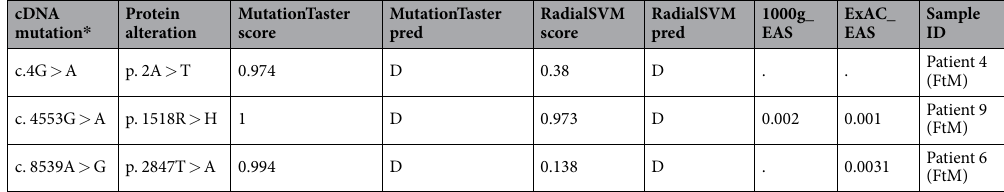
Table 1. Summary of RYR3 mutations in GD patients. * The accession number for RYR3 is GenBank NM_001036.